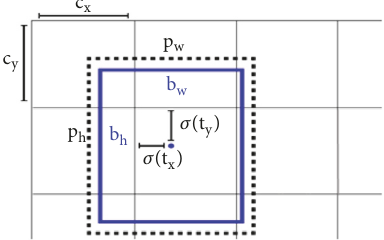
Figure 3: Bounding boxes with dimension priors and location